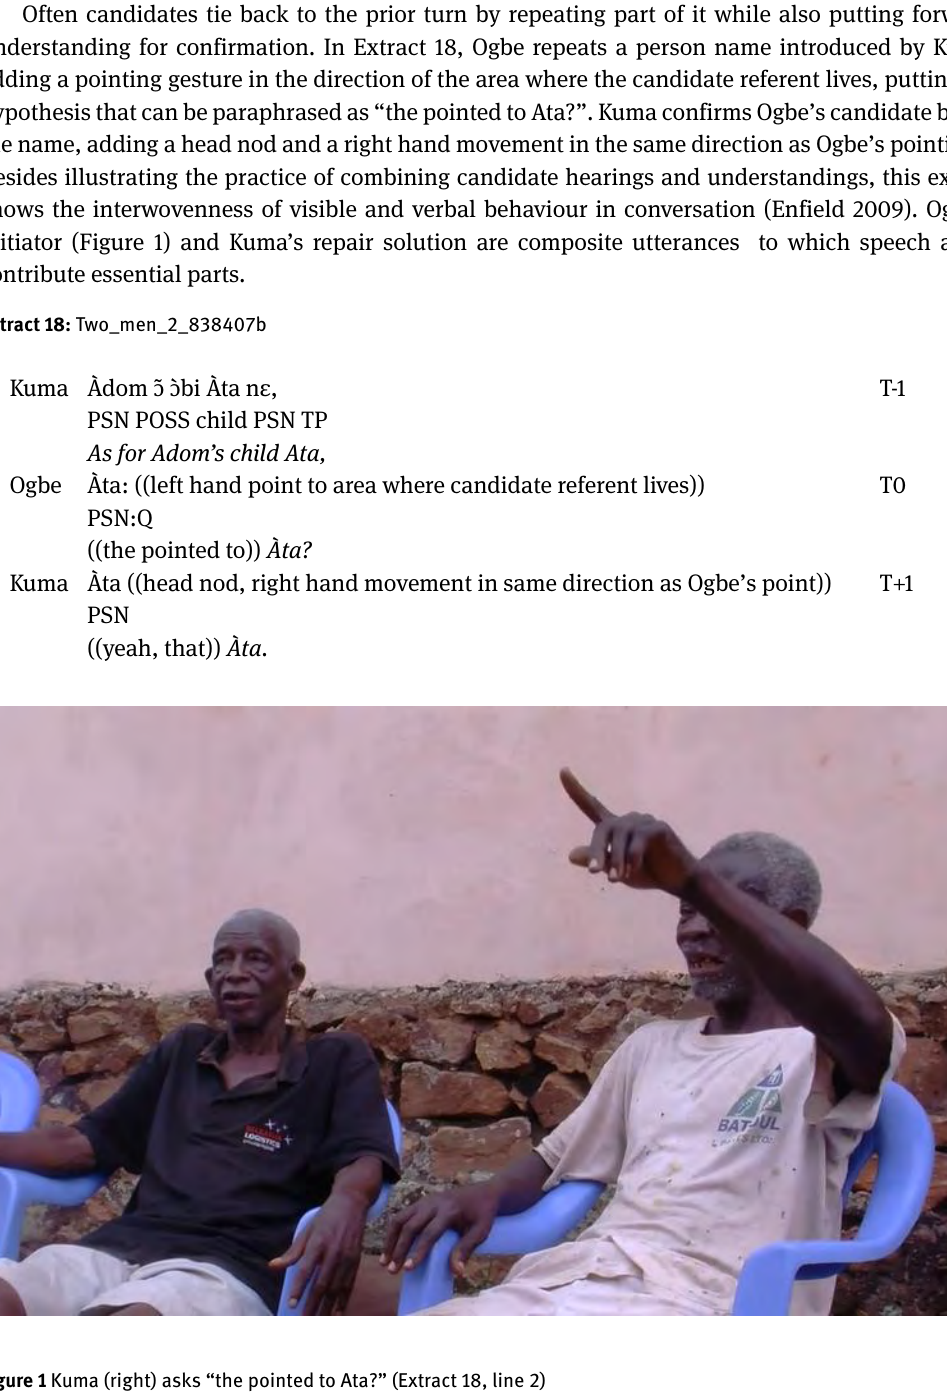
Figure 1 Kuma (right) asks “the pointed to Ata?” (Extract 18, line